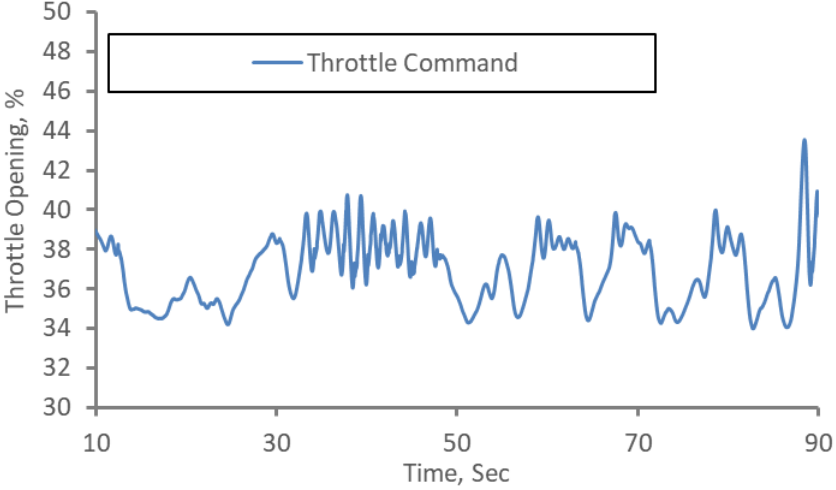
Figure 22. Throttle command of the engine speed controller.